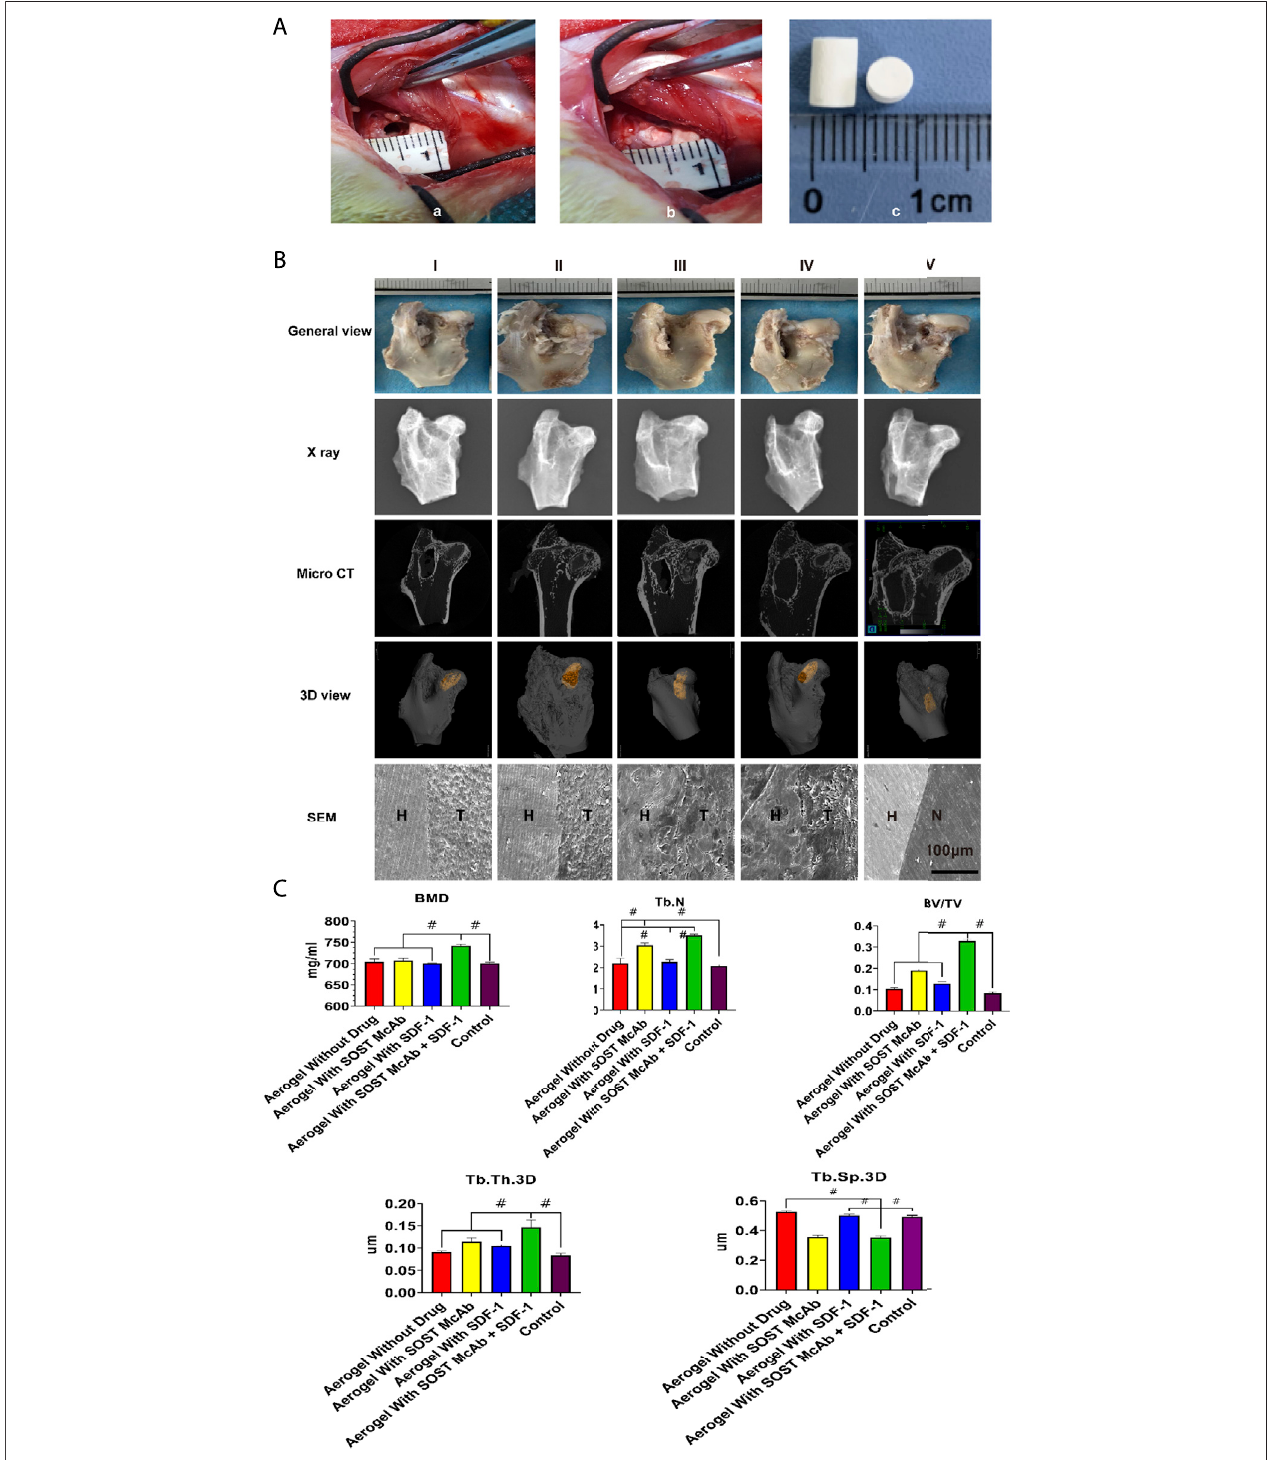
FIGURE 8 | The process and the results in vivo experiments. (A) the process in vivo experimental operation. The aerogel scaffold was implanted after drilling holes at thejunctionoftheheadandneckofthefemurinrabbits.a)showsthe4 mmdiameterofthehole;b)showstheimplantationoftheaerogelscaffoldat thedrillhole;c)is the diameter of the implanted aerogel stent, which is 5 mm (B) . Observation of New Zealand rabbits implanted with different aerogel scaffolds. There was no obvious collapse of the femoral head in all groups. X-ray and Micro CT showed that there were different degrees of new bone formation in the osteonecrosis area in the aerogel scaffold implanted group (I-IV), while in the group only drilled without aerogel implantation (V), only a small amount of new bone formed at the beginning of the